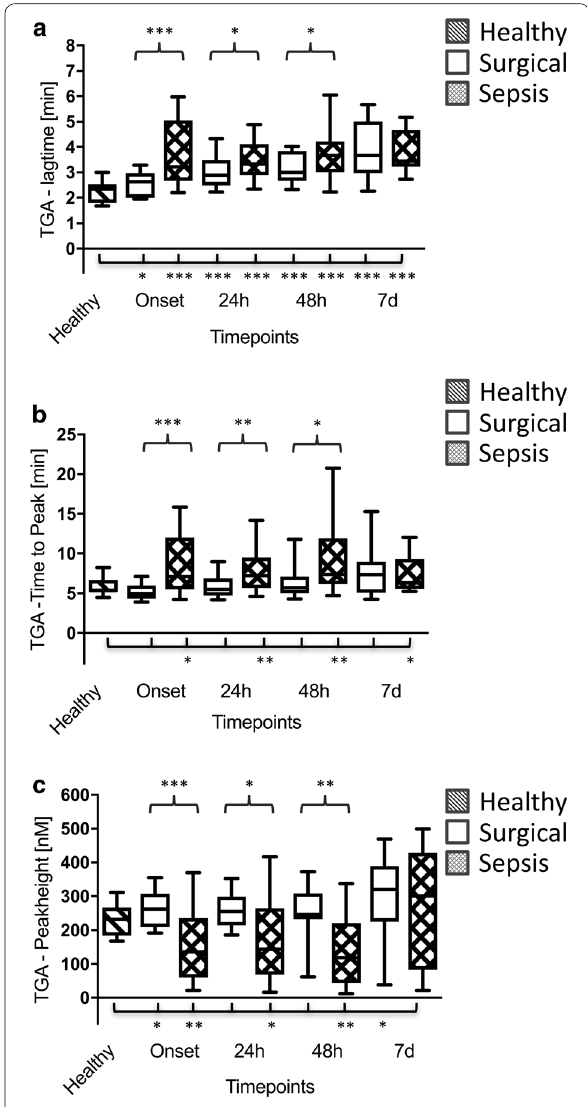
Fig. 4 Thrombin generation assay (TGA) lag time ( a ), time to peak ( b ) and peak height ( c ) in healthy volunteers ( n 30; striped bars), = surgical patients ( n 30; white bars) and patients with septic shock = ( n 30; squared bars). Data of patients with septic shock and surgical = patients are presented for the timepoints onset (sepsis onset or immediately after the surgical procedure) as well as 24 h, 48 h and 7 d later, whereas blood samples from healthy volunteers were collected only once. Data in box plots are given as median, 25th percentile, 75th percentile with the 10th and 90th percentile at the end of the whiskers. A P value < 0.05 was considered statistically